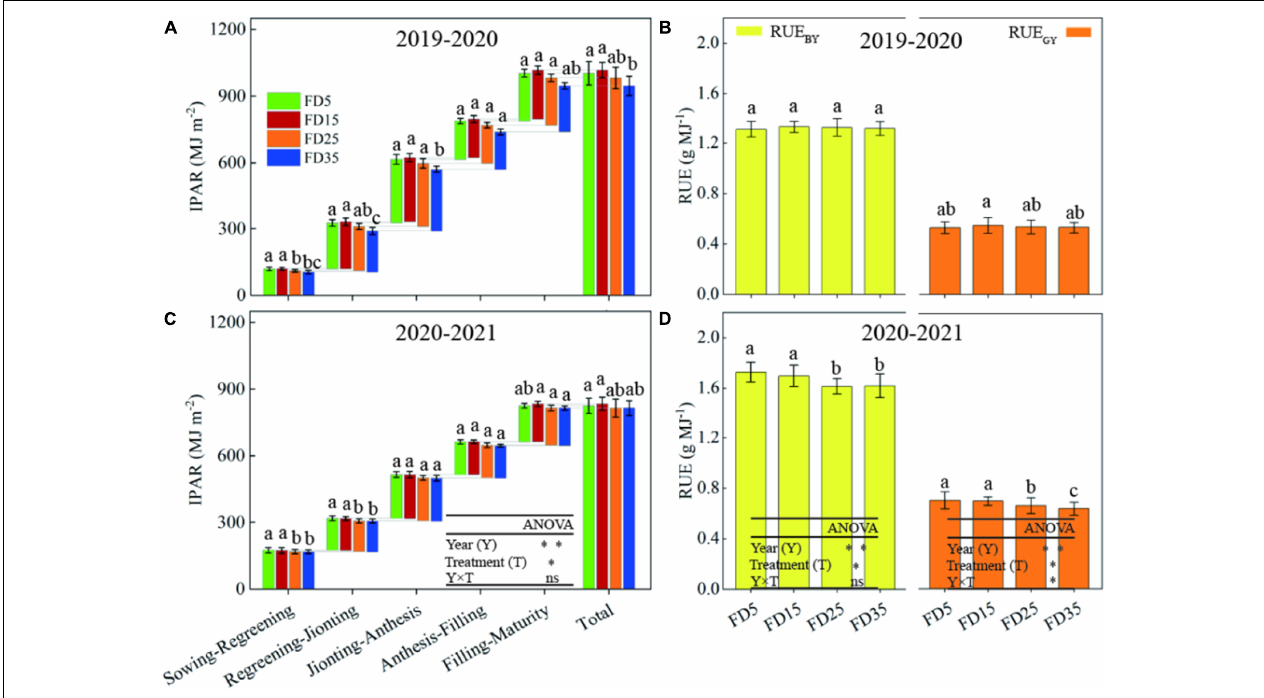
FIGURE 11 | Winter wheat IPAR (A,C) and RUE (B,D) in 2019–2020 and 2020–2021. FD5, fertilizer application at a depth of 5 cm; FD15, fertilizer application at a depth of 15 cm; FD25, fertilizer application at a depth of 25 cm; FD35, fertilizer application at a depth of 35 cm; RUE GY , radiation use efficiency based on grain yield; and RUE BY , radiation use efficiency based on biomass yield. The vertical bars stand for standard deviation. The different lowercase letters indicate a significant difference among the treatments at P < 0.05 using the LSD method. ns, no significant difference; ∗ , significant at P < 0.05; ∗∗ , significant at P <